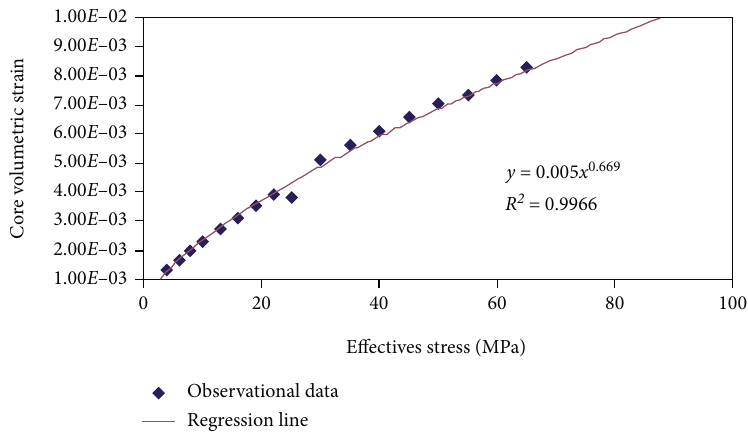
Figure 4: Relationship between core volumetric strain and e ff ective stress.